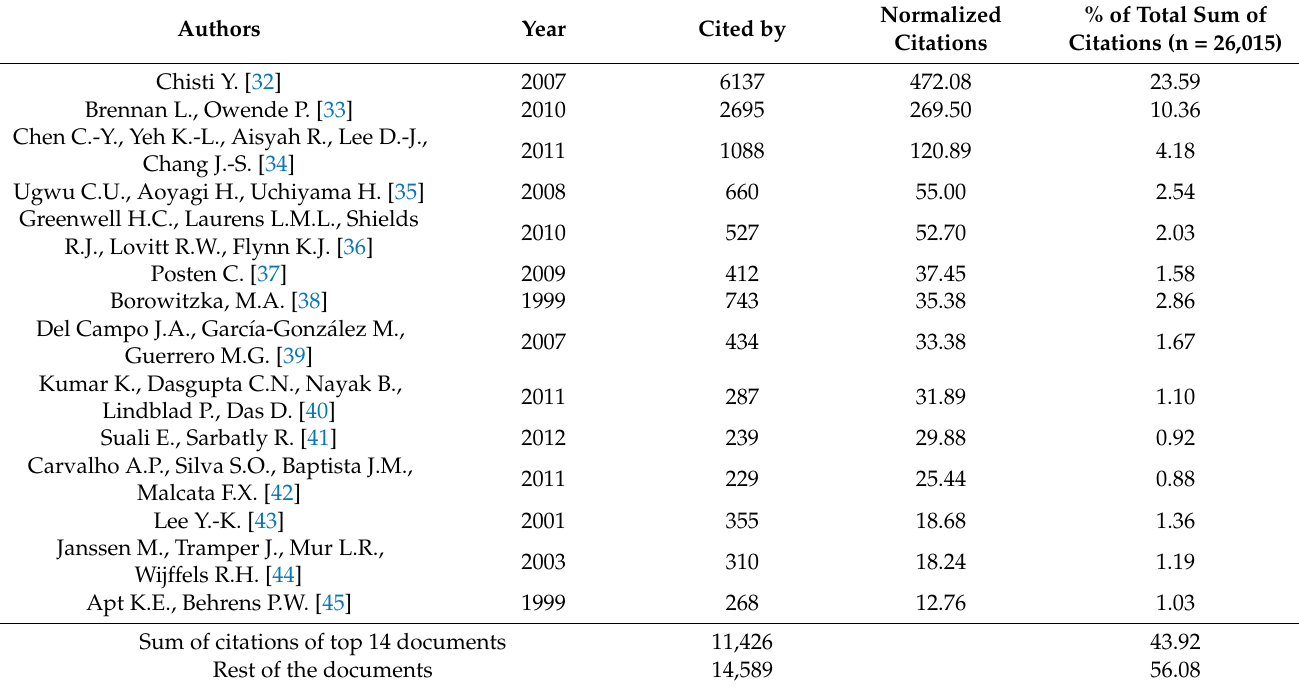
Table 2. Articles with high numbers of